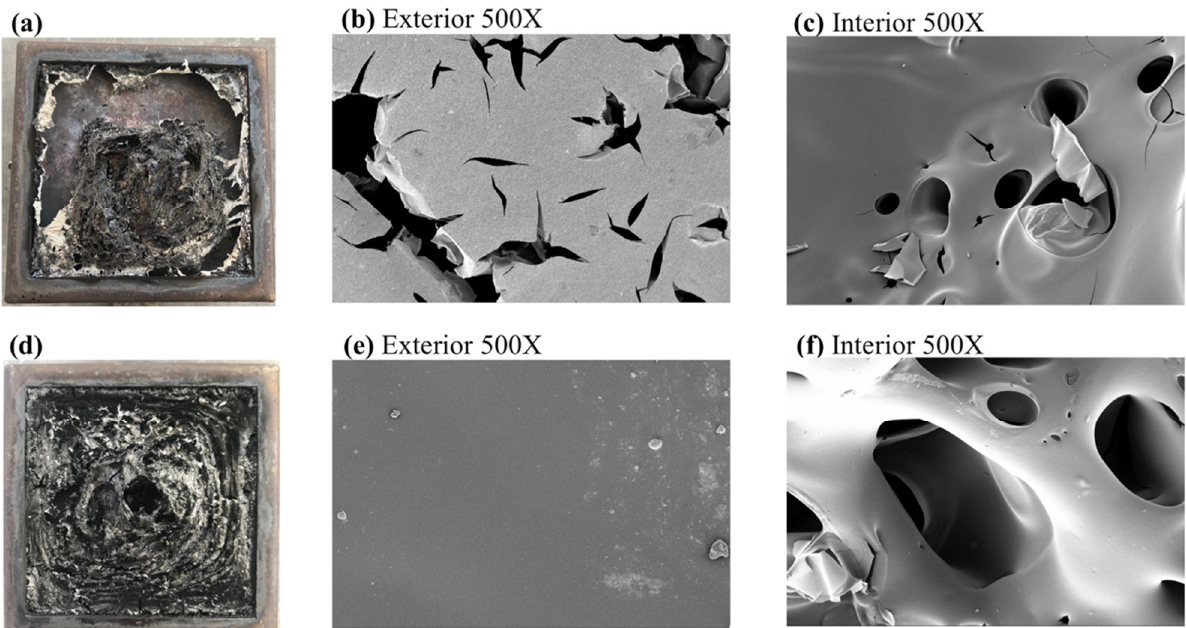
Figure 7. Digital and FESEM images of CCT residual chars, ( a – c ) neat MXD6 and ( d – f ) MXD6/DT/P22.